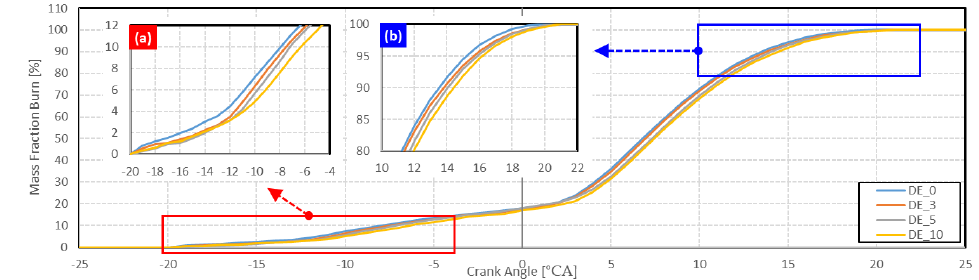
Figure 5. Mass Fraction Burned. ( a ) CA10 and ( b ) CA90.